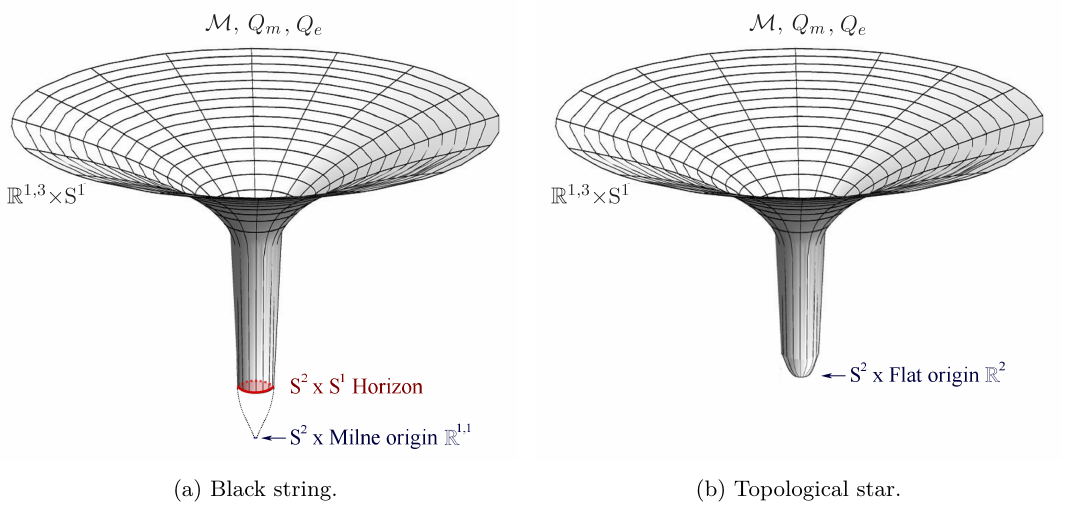
Figure 1 . The two types of spherically symmetric static solutions of our five-dimensional Einstein- Maxwell theory. The solutions have a four-dimensional mass M and are supported by electromag- netic fluxes with conserved magnetic and electric charges ( Q